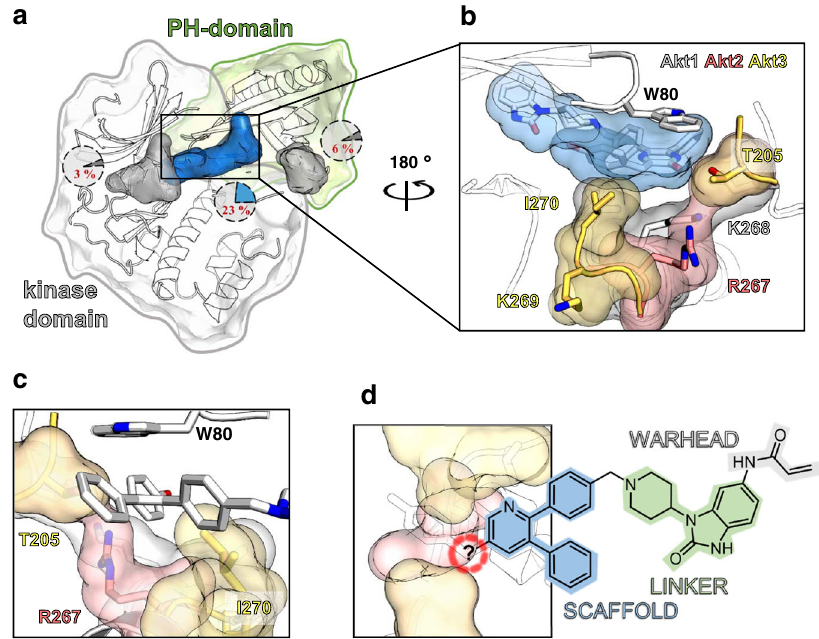
Fig. 2 Homology-model guides design of covalent-allosteric inhibitors to address Akt isoforms. a General overview of the closed conformation of protein kinase Akt (kinase domain: gray, PH domain: green; based on PDB: 6HHF) 36 and the druggable binding pockets (ATP-pocket within kinase domain: gray (PDB: 4GV1) 52 , allosteric-interdomain pocket: blue (PDB: 6HHF), PIP 3 -binding pocket within PH domain: gray (PDB 2UVM) 53 ). The variety of the binding site forming residues among the three isoforms are given in percentage; b View of the interdomain binding site in Akt1 (white; PDB 6S9X: with the covalent-allosteric Akt inhibitor 15c (blue)) 17 in comparison to homology models of Akt2 (red) and Akt3 (yellow). The structural changes within the allosteric site and the different side chain residues of each isoform are highlighted; c Modeling studies with recently found pyrazinonic CAAI 16c into Akt isoform homology model highlight structural differences and possible interactions within the allosteric binding site (Akt1(white) PDB: 6S9X; Akt2 (red) and Akt3 (yellow) homology model) 17 . The side view shows an enlarged space in Akt2 and Akt3, ideally to allow the binding of the hydroxyl phenyl moiety (Supplementary Fig. 4); d Structure-guided design approach towards a focused set of small molecules for evaluation of Akt isoform-selectivity: trisubstituted, biarylic pyridines function as core scaffold (blue). A benzimidazolone linker (green) is decorated with the Michael acceptor warhead (gray) to address the nucleophilic cysteine residues within the allosteric binding site. Different moieties (red) with various chemical properties and spatial demand should be connected over a de fi ned linkage to the core